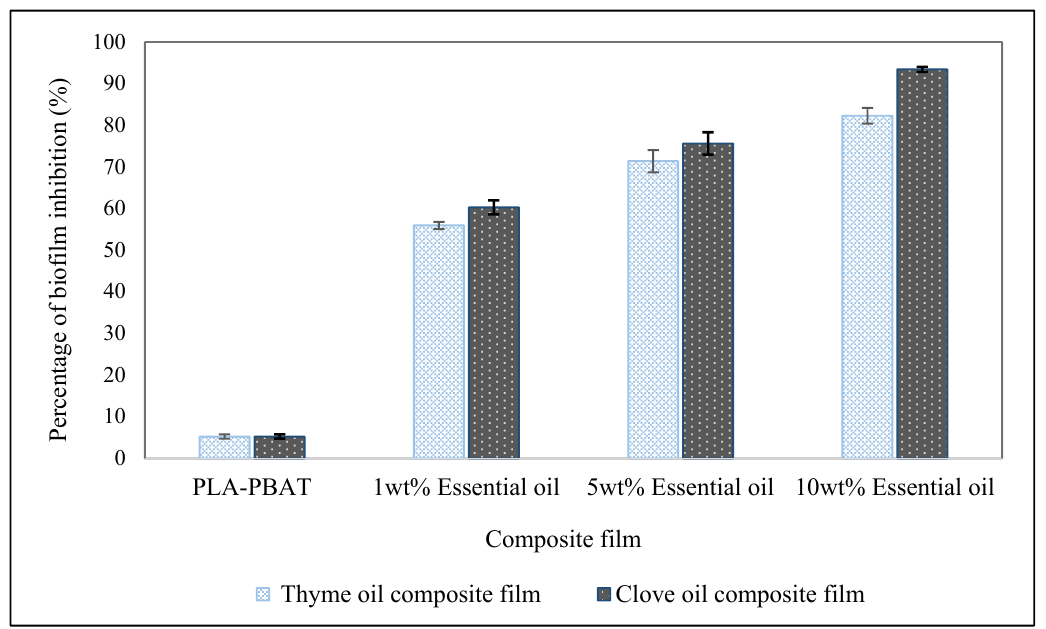
Figure 4. Biofilm inhibition of PLA / PBAT-Thyme oil composite film and PLA / PBAT-Clove oil composite film against E. coli.